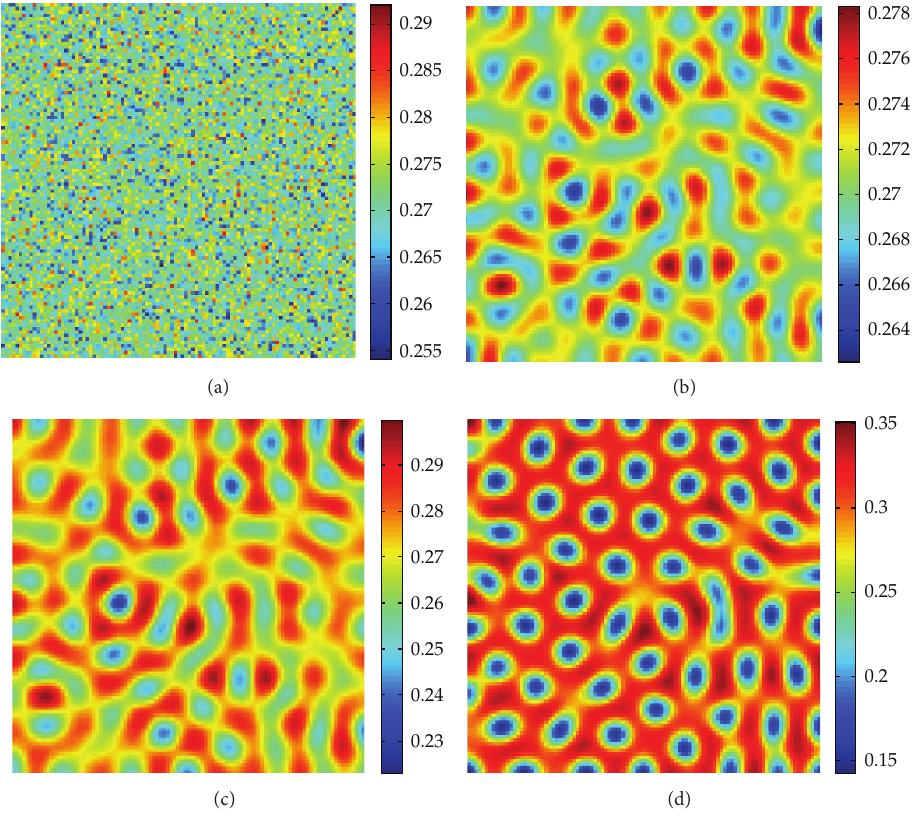
Figure 8: Spots pattern of 𝐻 in model (8) for 𝑚 = 0.75 . Times: (a) 0, (b) 500, (c) 1000, and (d) 2000.